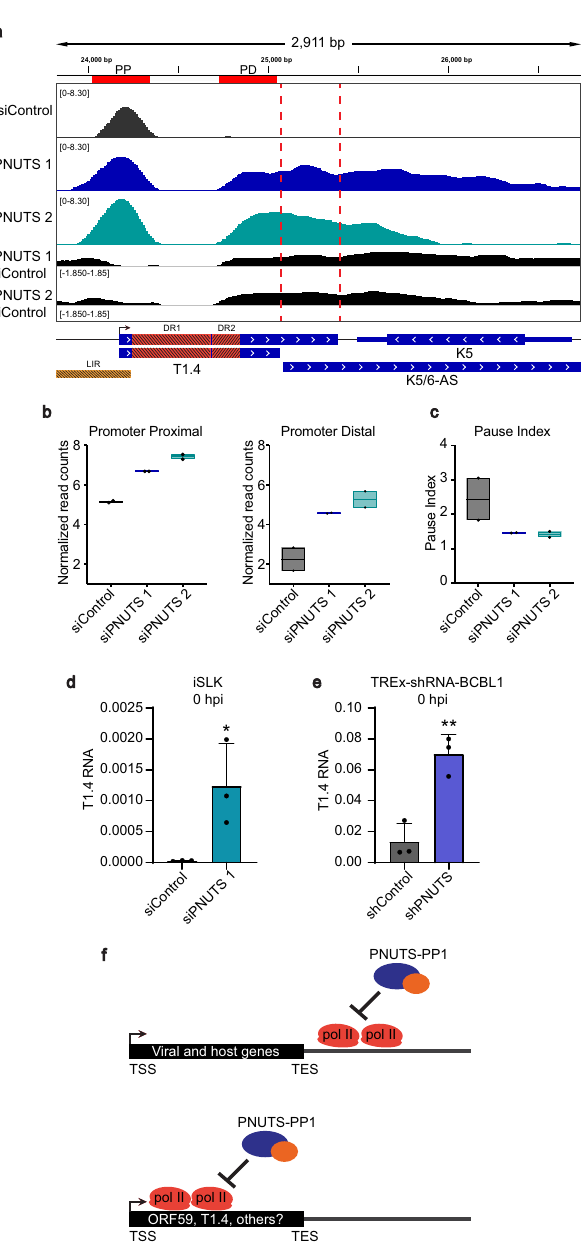
Fig. 6 | PNUTS depletion increases transcriptional output of a viral gene reporter by decreasing promoter-proximal pausing. a Schematic of the mod- i fi edreporter used for ChIP-seq and 4SUexperiments. A and B mark the 4SU-qPCR amplicon locations. b RT-qPCR of 4SU-labeled RNA following a 10min 4SU pulse before sample harvesting and 4SU selection. Amplicon levels were normalized to 4SU-labeled beta-actin and quanti fi ed relative to siControl. Error bars are mean with standard deviation, asterisks denote Student ’ s two-tailed unpaired t-test: (ORF59 siControl vs siPNUTS 1 ** p =0.0060, siControl vs siPNUTS 2 ** p =0.0066; Readthrough siControl vs siPNUTS 1 *** p =0.0009, siControl vs siPNUTS 2 n.s. p =0.0684), ( n =3). c Representative IGVimagesof humangenesGAPDH andMYC ChIP-sequencing pro fi les in non-targeting control (dark gray), siPNUTS 1 (dark blue),andsiPNUTS2(teal).Bottomtracksarerelative(Log2ratio)polIIoccupancy comparing PNUTS-depleted samples to non-targeting control; black and